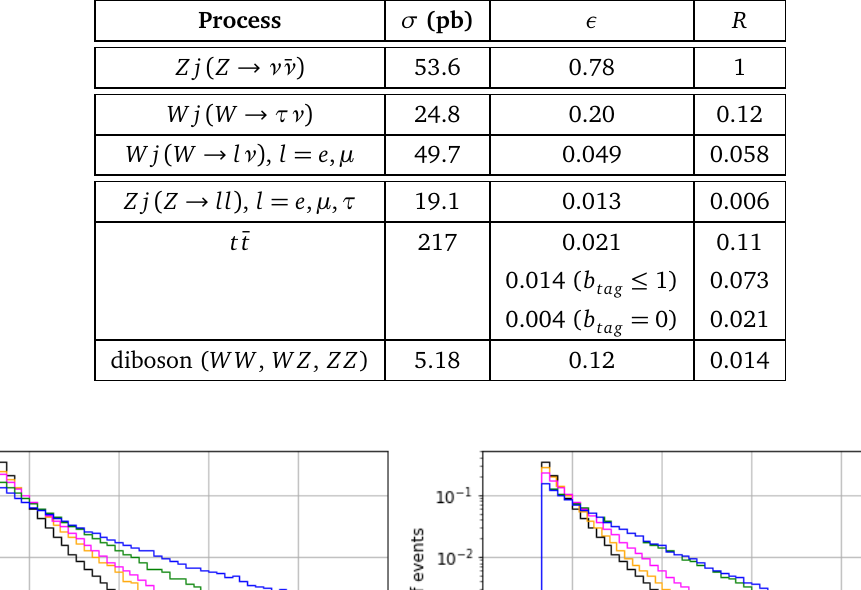
Table 3: Process relative contribution ( R ) of several SM monojet plus missing trans- verse energy backgrounds, with respect to the dominant SM channel, Z j ( Z → ν ¯ ν ) .